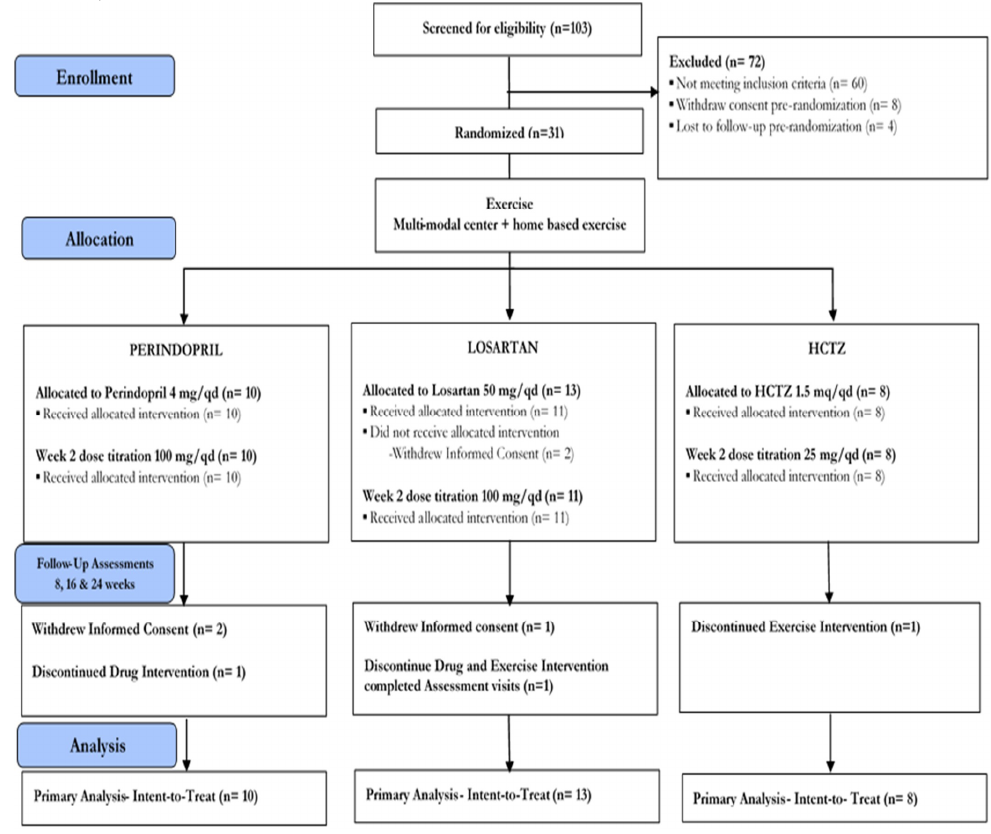
Figure 2. Participant flow through the study.